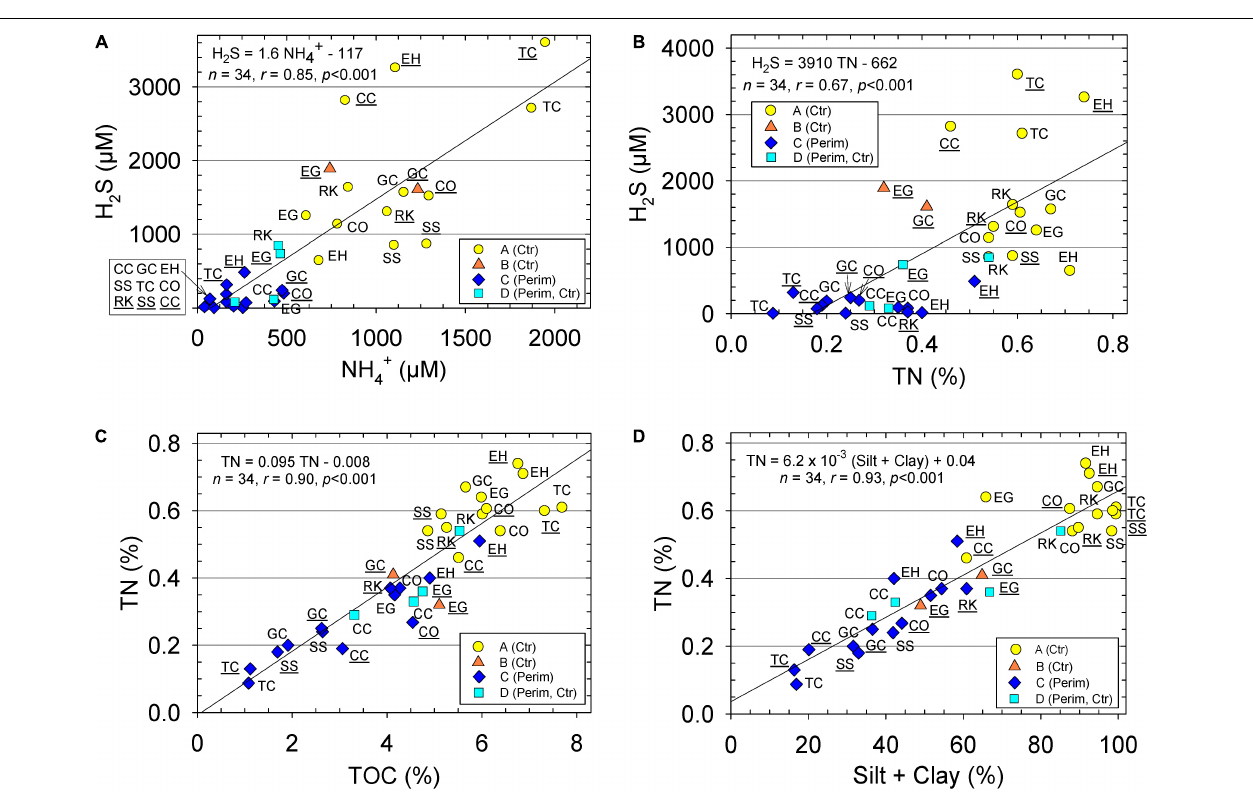
FIGURE 3 | Sediment (A) porewater hydrogen sulfide (H 2 S) vs. ammonium (NH 4 + ), (B) porewater dissolved H 2 S vs. sediment total nitrogen (TN), (C) concentrations of TN vs. total organic carbon (TOC) and (D) concentrations of sediment TN vs. silt + clay content. Data for perimeter (Perim) and center (Ctr) deposits of muddy sediment. Equations and lines from linear regression, correlation coefficient ( r ), number of samples ( n ), and p statistic. Stations with ID underlined were sampled during wet season and with no underline during dry season. Groups determined from hierarchical cluster analysis are identified with different